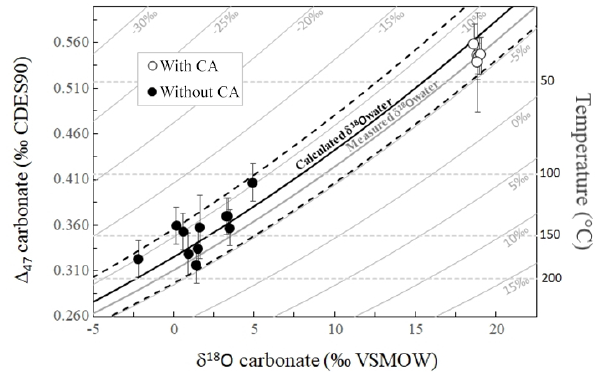
Figure 5. Combined δ 18 O carbonate and (cid:49) 47 disequilibria of mi- crobial carbonates precipitated at 30 ◦ C allow reconstruction of the δ 18 O of the water ( δ 18 O water ) in which they precipitate. Solid grey curves represent the calculated (cid:49) 47 and δ 18 O carbonate compositions of carbonates precipitated at oxygen isotope equilibrium from water with fixed δ 18 O water values (indicated on each curve) and variable temperatures. Horizontal dashed grey lines are calculated for fixed temperatures and variable δ 18 O water . The average δ 18 O water value of − 6 . 6 ± 0 . 4‰ measured in our experiments is reported using the thick solid grey curve. The solid black curve was obtained using the δ 18 O water calculated with Eq. (2) ( − 8 . 0 ± 2 . 8‰) with its associated errors (dashed black